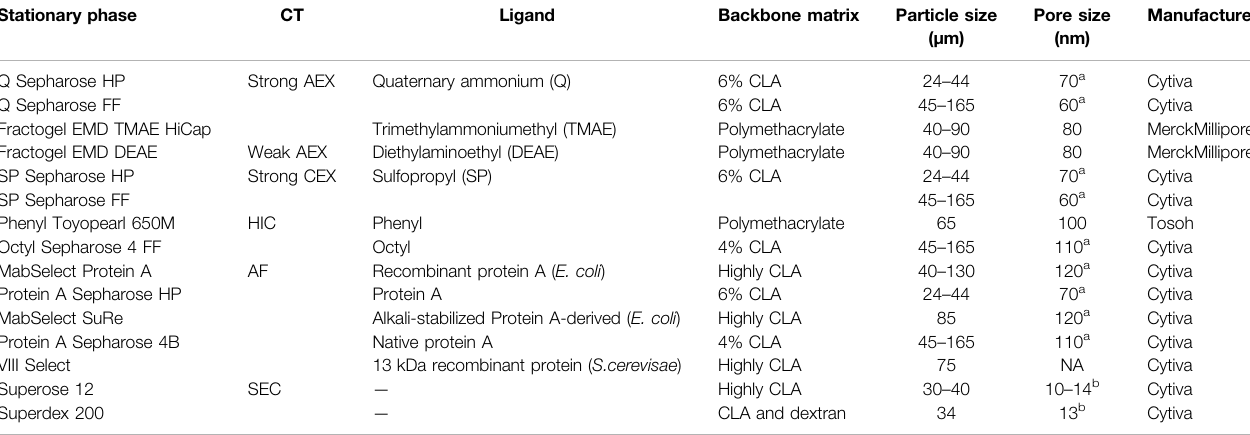
TABLE 4 | Structural properties of resins used to purify commercial Fc-fusion proteins. Information is based on manufacturer ’ s data sheets unless cited otherwise. Stationary